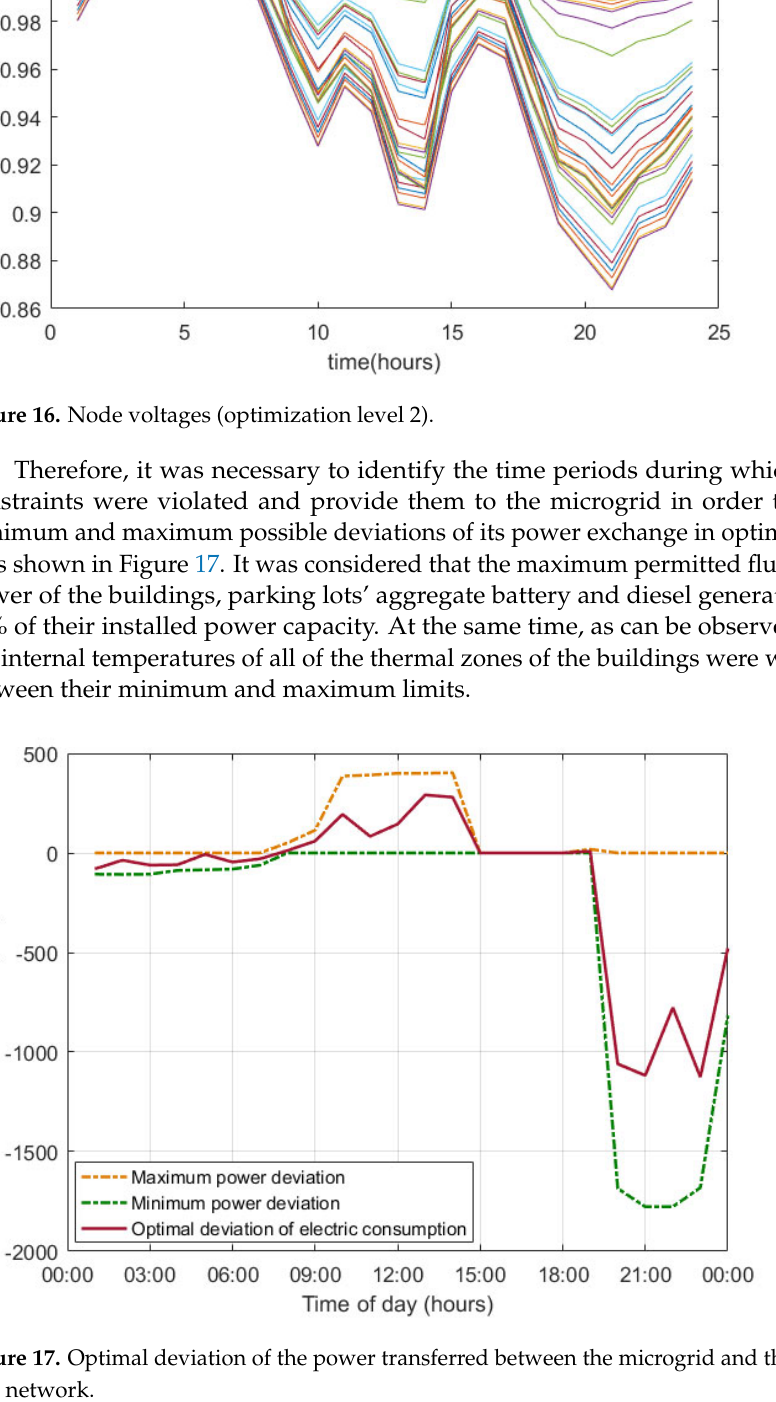
Figure 16. Node voltages (optimization level 2).